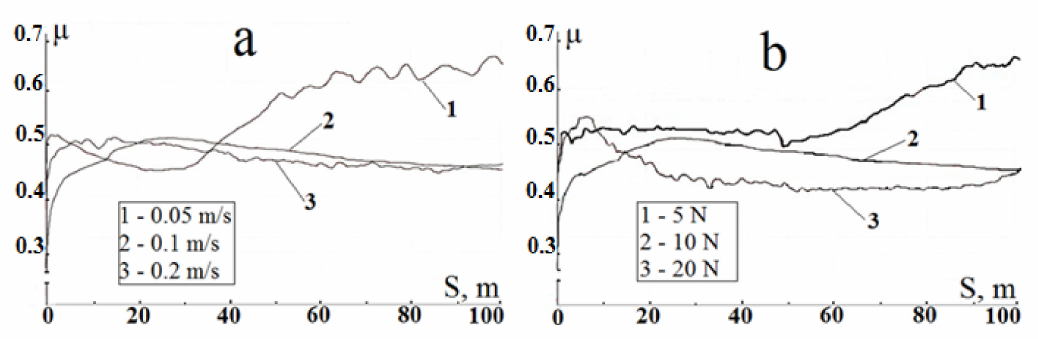
Figure 9. Friction coefficient as a function of sliding distance during the test initial samples: ( a ) at constant load of 10 N and variable sliding velocities 0.05, 0.1, and 0.2 m/s, ( b ) at constant sliding velocity of 0.1 m/s and variable loads 5, 10, and 20